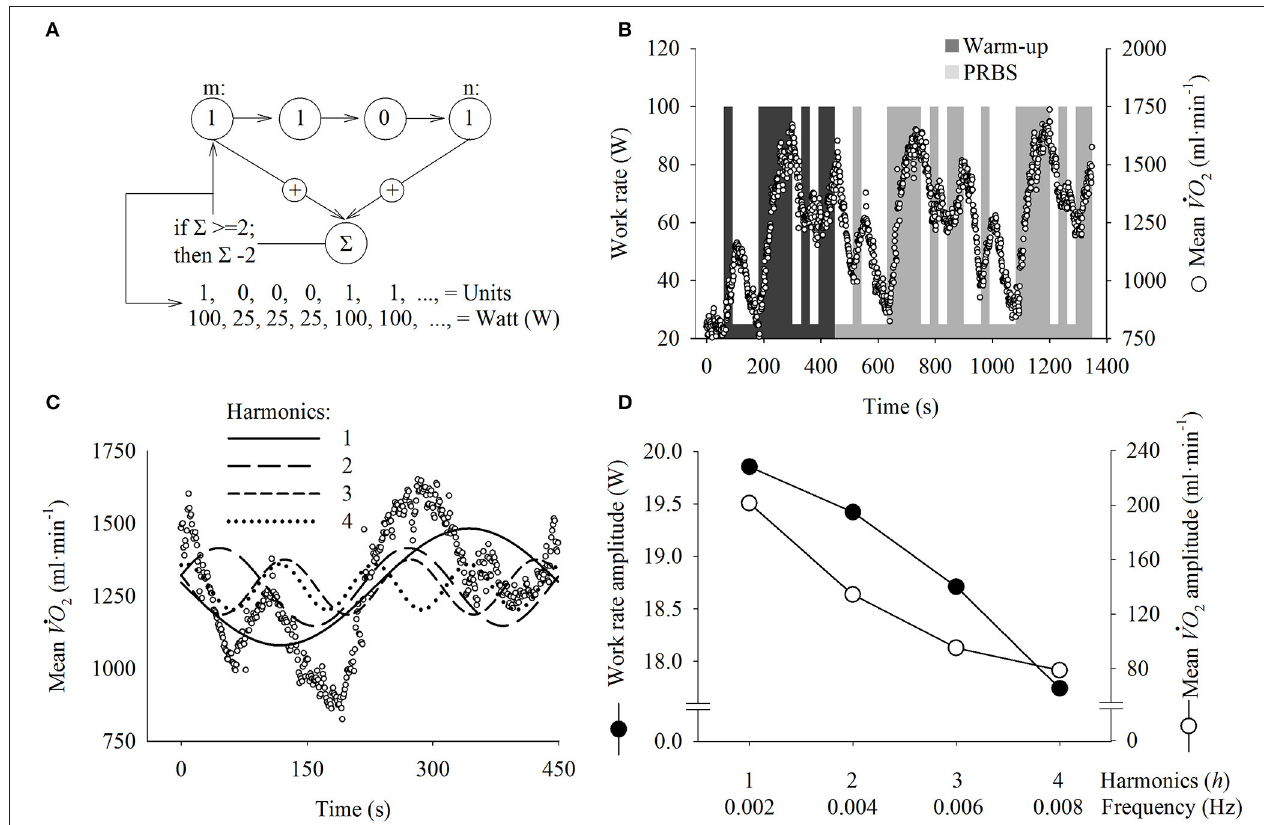
FIGURE 1 | (A) Illustration of the 4-stage shift register used to generate the pseudorandom binary sequence protocol (PRBS). The module addition feedback ( sums the first and fourth stage values and tests the “if” statement. The value is then inserted into the first stage and the entire system shifts to the right, and the sequence repeats after 15 values. Each unit is maintained for 30s to create the PRBS protocol in the time-domain (B) . The system input stimulates the oxygen uptake ( ˙ VO 2 ) response ( − ), here represented by the mean signal of all participants ( n = 8) during the first visit. The ˙ VO 2 data regarding the first PRBS sequence (warm-up) were excluded a priori . (C) To illustrate the frequency domain analysis, Fourier transformations were used to decompose the ˙ VO 2 time-domain response of the second PRBS sequence into amplitudes of sinusoidal functions at specific frequencies (i.e., harmonics). The amplitudes of the system input (i.e., work rate in Watts) and output (i.e., ˙ VO 2 ) at different frequencies are displayed in (D)